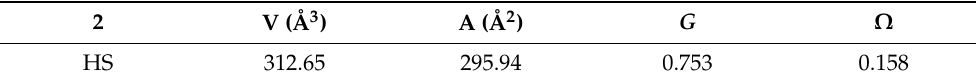
Table 2. Characteristics of the HS generated for 2 .